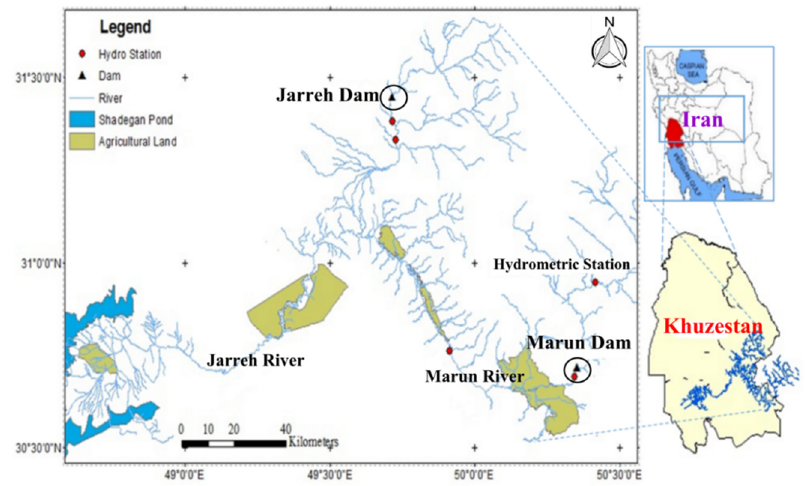
Figure 1. Location of the studied rivers in the Maroon and Jarahi basin.